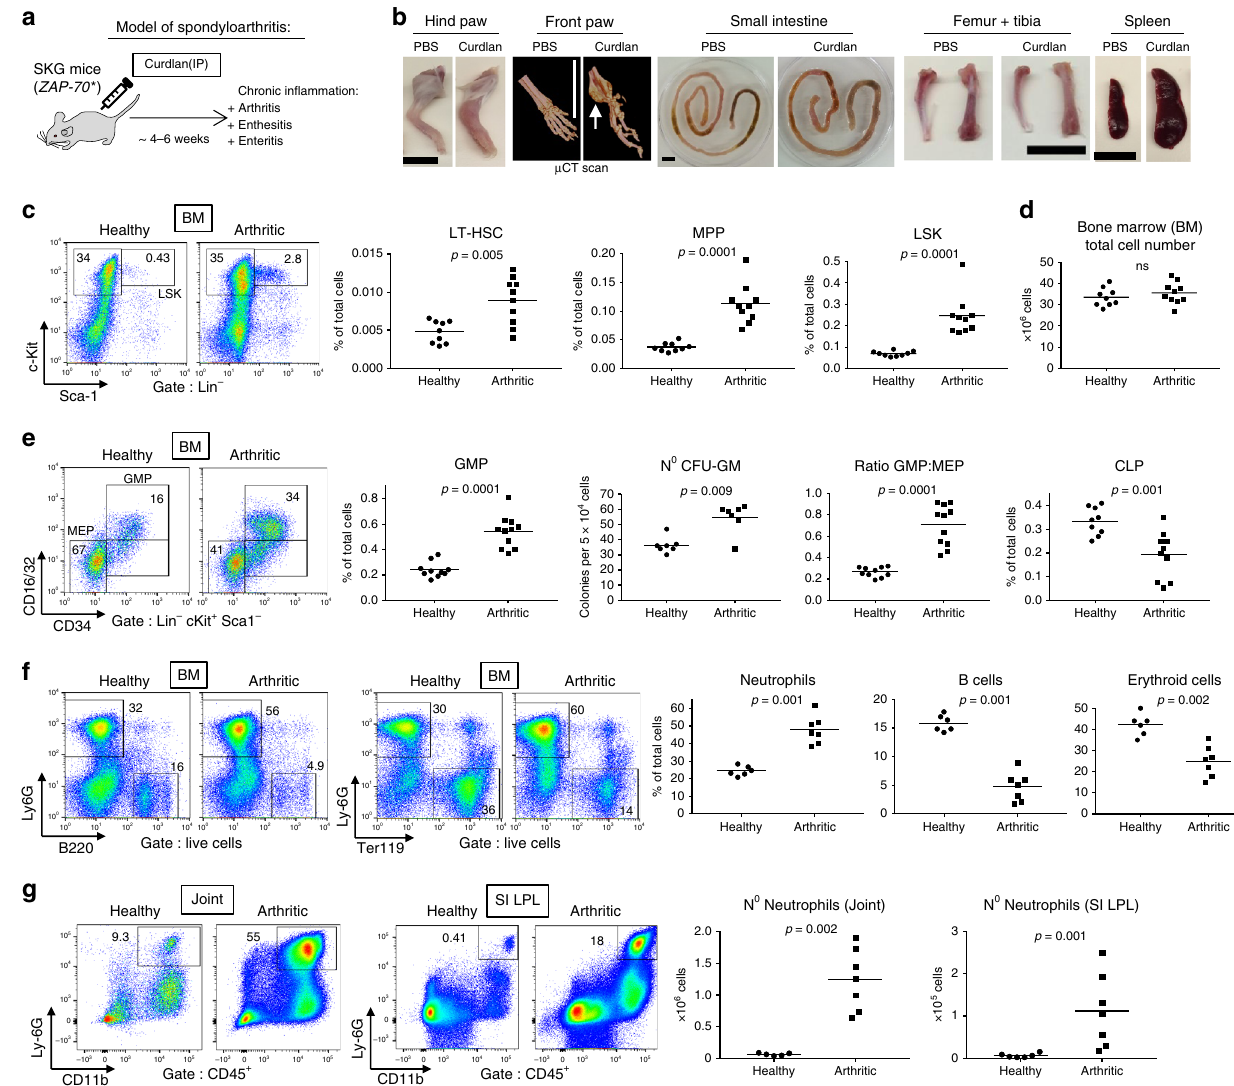
Fig. 1 Hematopoiesis is biased toward myelopoiesis during experimental SpA. a Experimental protocol to induce spondyloarthritis (SpA) in SKG mice. Single injection of curdlan IP causes non-resolving in fl ammation of joints, entheses, and small intestine (SI). Samples derived from such “ arthritic ” SKG mice culled 4 – 6 weeks after triggering were compared with PBS-injected “ healthy ” SKG mice ( b – g ). b Images of gross pathologic changes observed during SpA in SKG mice. Front paw: 3D-reconstructed ex vivo µ CT radiographs of front paw. Arrow shows new bone formation characteristic of SpA. Scale bars = 1 cm. c Staining of bone marrow (BM) cells with frequencies of progenitors (Sca-1 − cKit + ) and LSK cells (Sca-1 + cKit + ) among Lin − cells. Graphs show frequencies of long-term hematopoietic stem cells (LT-HSC), multi-potent progenitors (MPP), and LSK cells among total cells. d Total count of BM extracted from one tibia and one femur of each mouse. e BM staining for CD16/32 and CD34, showing frequencies of granulocyte macrophage progenitors (GMP) and megakaryocyte-erythroid progenitors (MEP) among Lin − cKit + Sca-1 − progenitor cells. Graphs show frequencies of GMP and common lymphoid progenitors (CLP), ratio of GMP:MEP, and number of myeloid CFU-GM colonies obtained from BM cells plated in methylcellulose medium. f Staining and graphs showing frequencies of mature neutrophils (Ly6G + ), B cells (B220 + ), and erythroid cells (Ter119 + red blood cells) among total BM cells. g Graphs and staining of cells from paws and small intestine (SI LPL), showing frequency and absolute number of neutrophils (CD11b + Ly6G + ). Dots represent individual mice; horizontal bars indicate mean. Data are representative of three independent experiments ( b – g ). Groups were compared using Mann – Whitney U tests. Source data are provided as Source Data fi